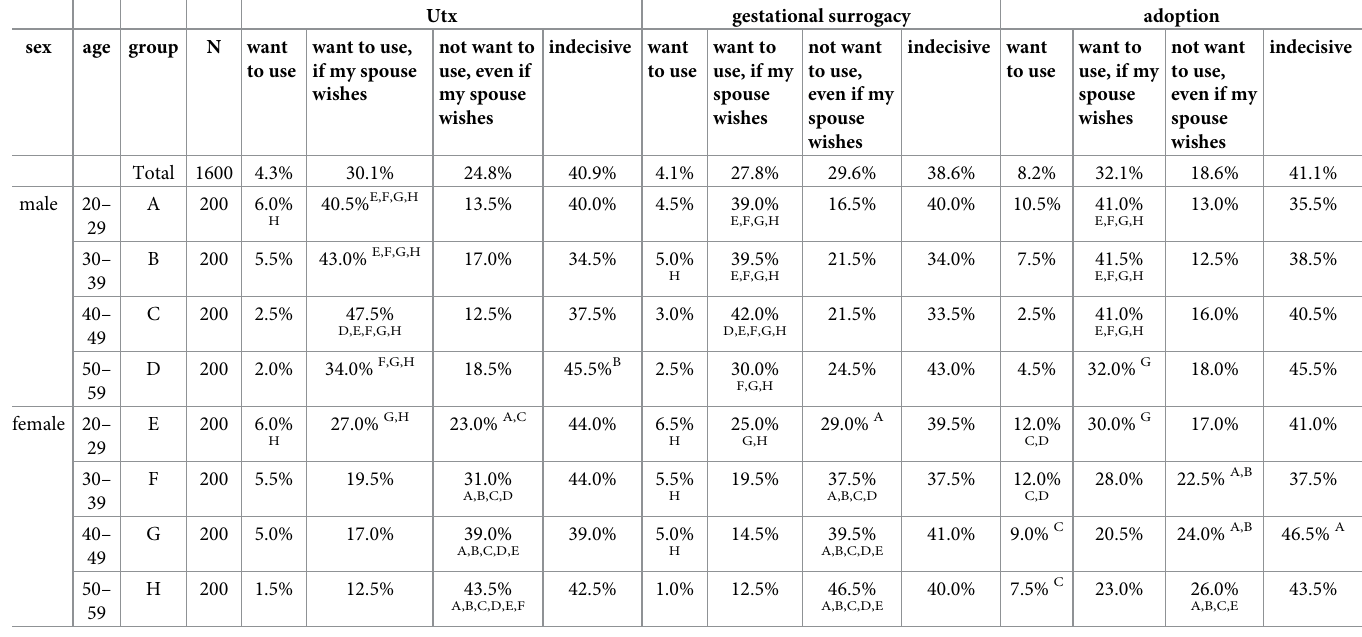
Table 7. Attitudes towards each UTx, gestational surrogacy, and adoption assuming that the respondents or their spouse are suffering from absolute. Utx gestational surrogacy